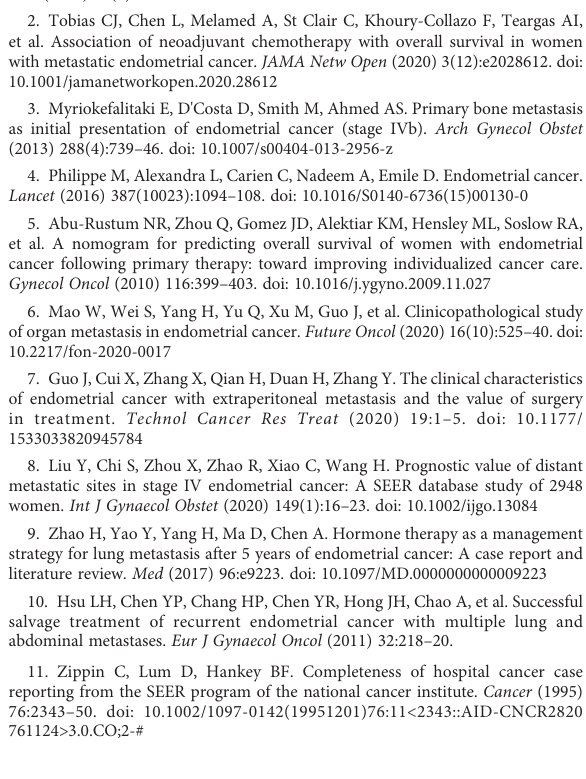
SUPPLEMENTARY TABLE 1 Histological type of EC used in the analysis. ICD-O-3, International Classi fi cation of Disease for Oncology (after